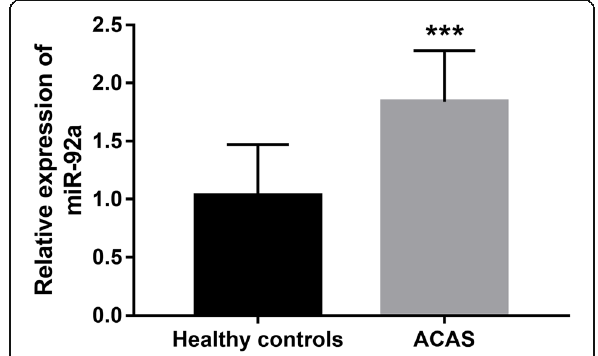
Fig. 1 Circulating expression of miR-92a detected by qRT-PCR in patients with ACAS. *** P <